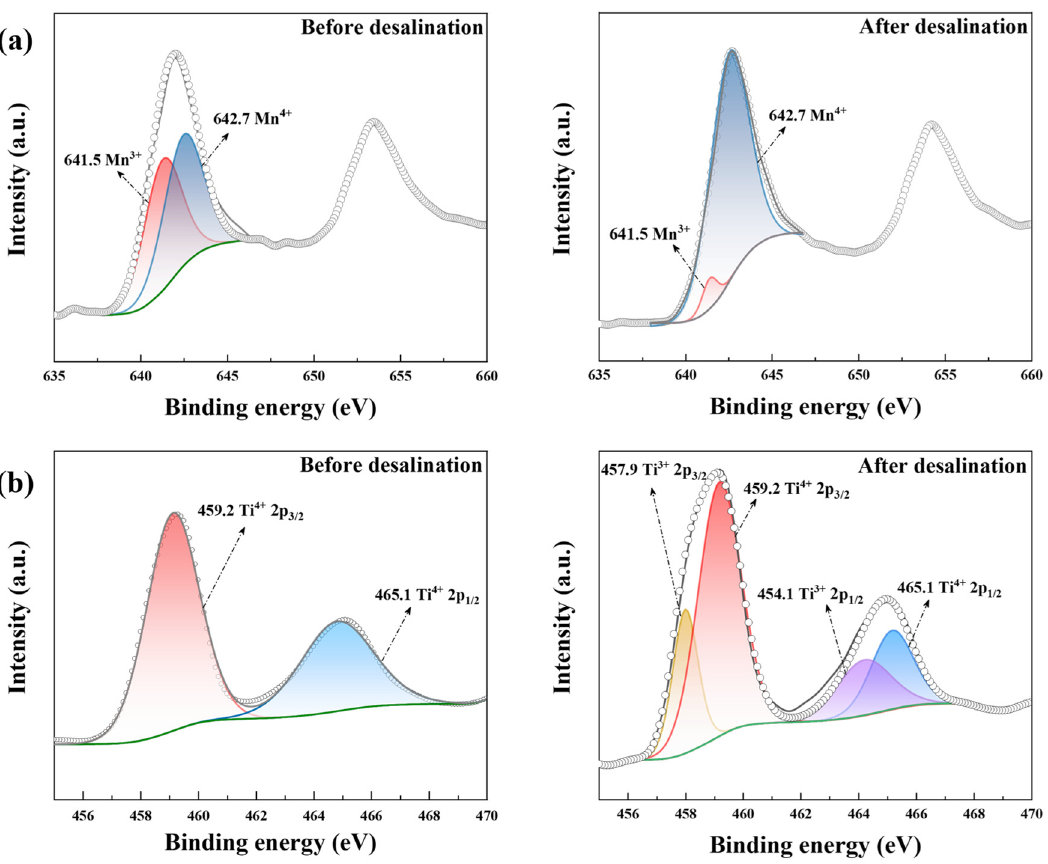
Figure 7. The XPS results of ( a ) Mn 2p in LiMn 2 O 4 /C and ( b ) Ti 2p in NaTi 2 (PO 4 ) 3 /C before and after the desalination test at 1.8 V in 10 mM salt solution.